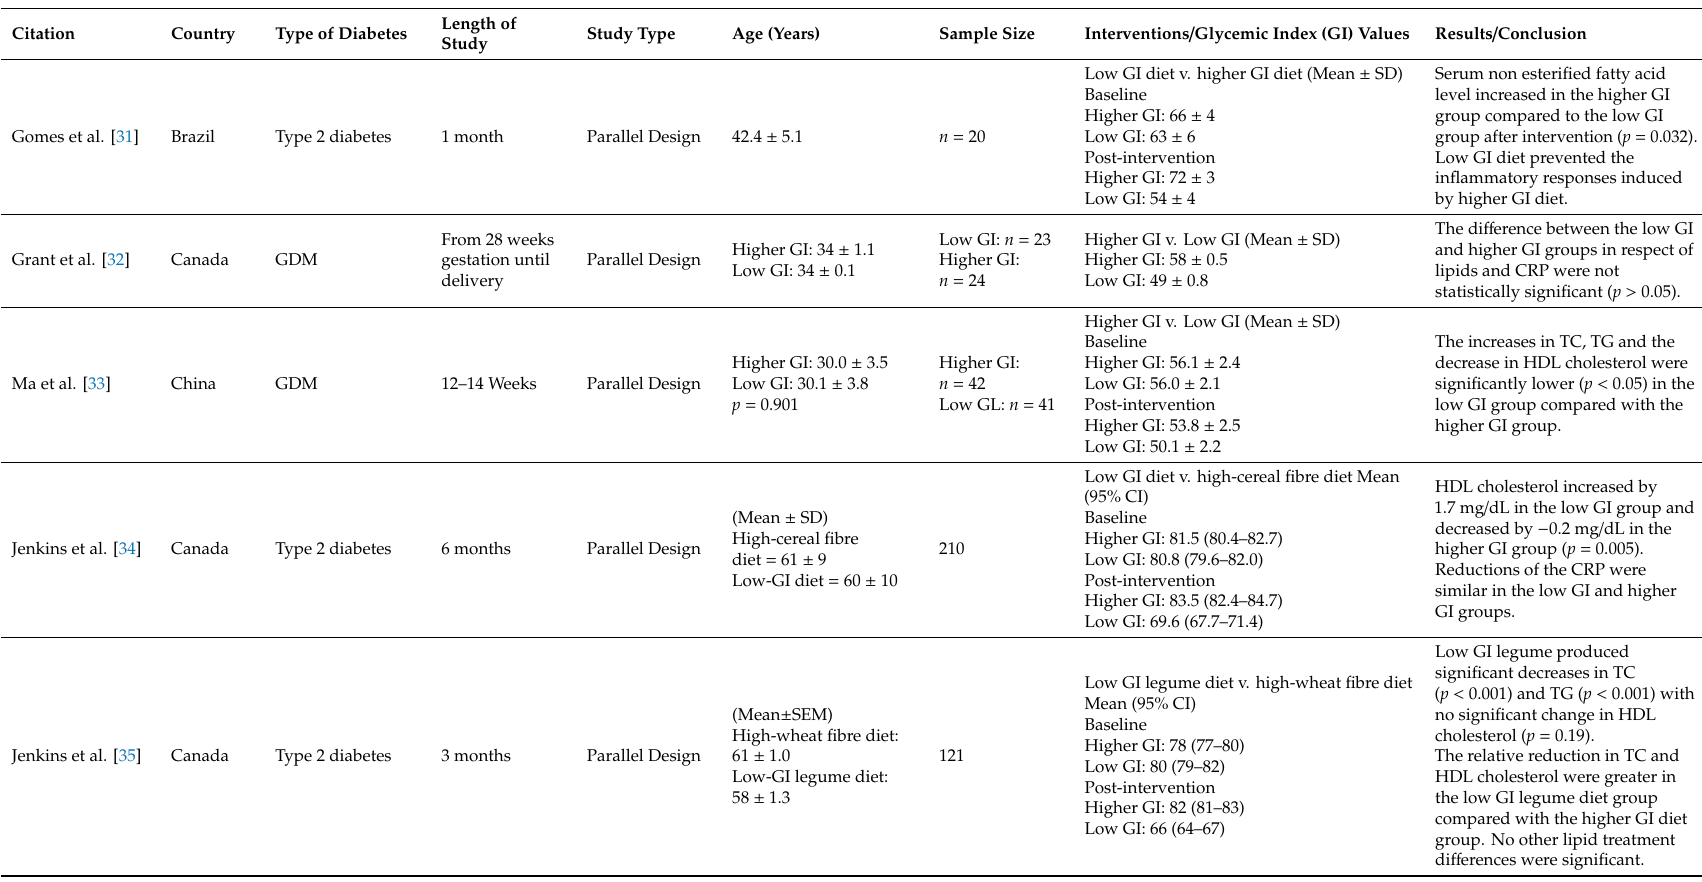
Table 3. The summary of studies selected for the